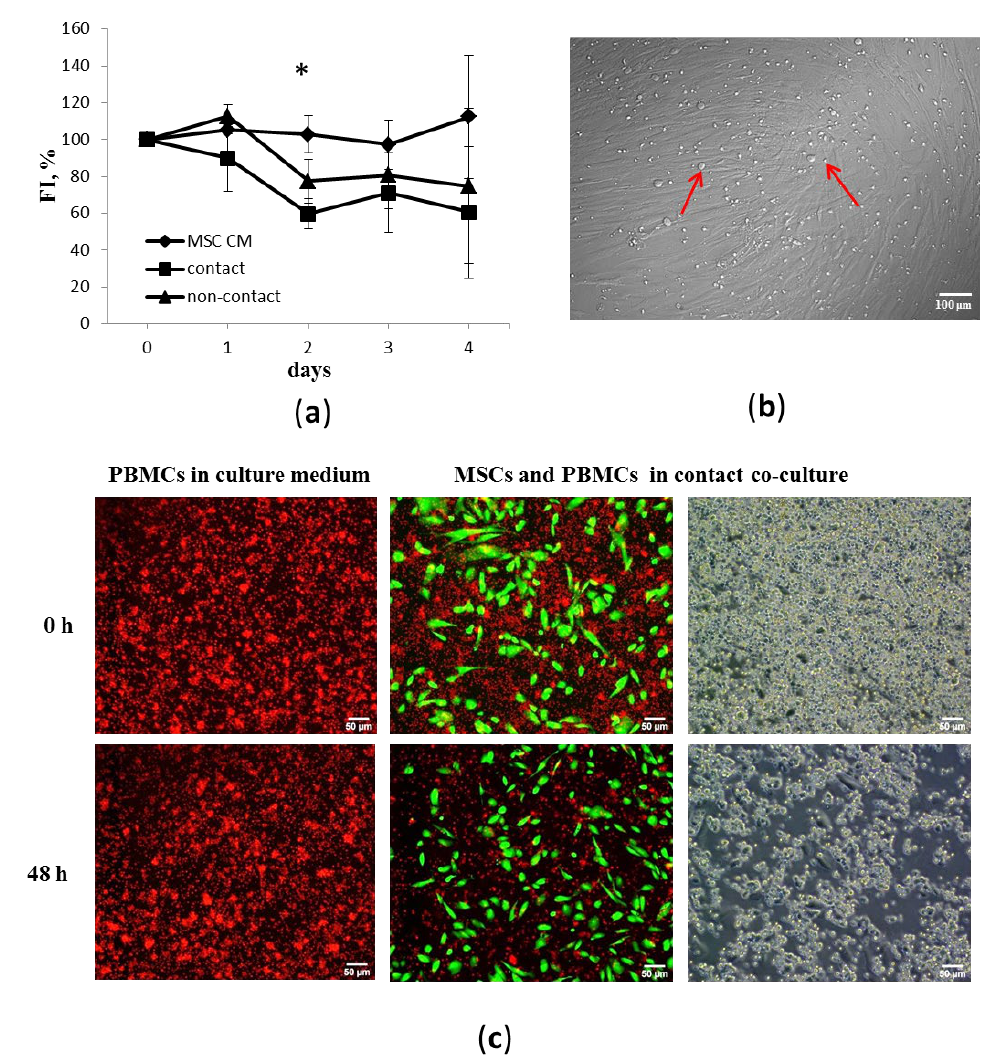
Figure 2. Effects of MSCs on PBMC proliferation. ( a ) Dynamics of PHA-induced proliferation of PBMCs incubated with MSC conditioned medium (MSC CM) or adherent MSCs in contact or non-contact co-cultures at a 25:1 ratio, respectively. Five unrelated donors per cell type were used. Average values and standard errors from five independent fluorescence intensity measurements using CyQUANT ® NF (FI) are shown. Data are normalized to the level of proliferation (100%) of PBMCs cultured in RPMI-1640 medium. Asterisk (*) indicates the reliability of differences at p < 0.05. ( b ) Red arrows indicate immune cells that formed close contacts with MSCs. Representative images of MSC and PBMC co-cultures after removing supernatant with nonadherent immune cells, phase contrast. ( c ) Representative images of live cells showing suppressive effect of MSCs (green) on PBMC proliferation (red) (CellTrace ™ calcein green and red-orange AM staining).